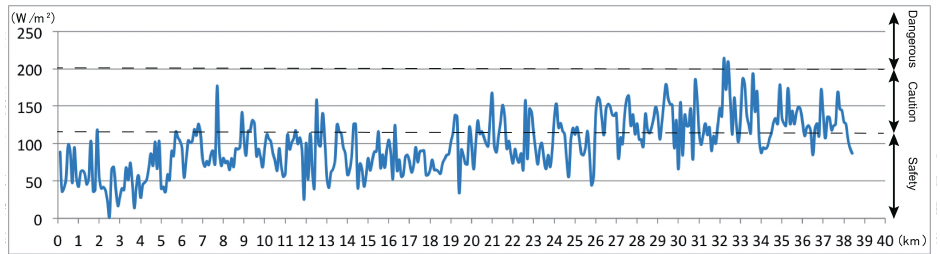
Figure 8. Energy budget for the best-case scenario graphed as a function of distance.